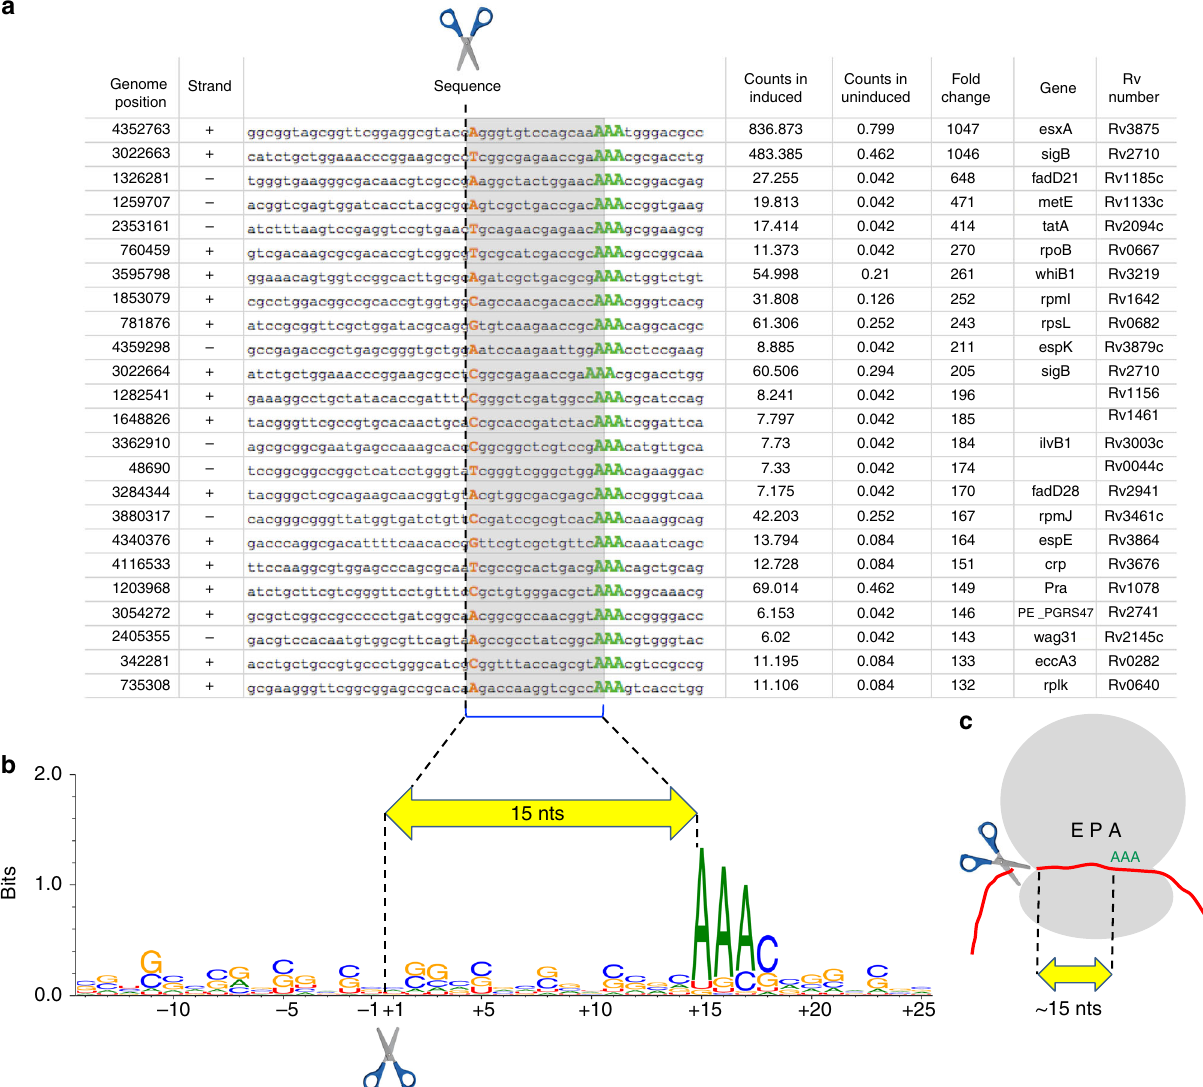
Fig. 2 5 ′ RNA-seq captures ribosome stalling events at AAA Lys codons. a Top mRNA hits detected by 5 ′ RNA seq, ±25 nts surrounding the cleavage site (scissor). The fi rst nucleotide of each mapped read, orange; AAA Lys codons, green. Counts are represented as reads per million (rpm). b Nucleotide frequency logo (weblogo, see ref. 37 ) at each position constructed from the top 50 of the 181 mRNA hits identi fi ed. Positions numbered relative to the cleavage site. c Schematic of a ribosome (gray) and the ~15 nt length (yellow arrow) from the 5 ′ end of transcript to the A-site. Source data are provided in Supplementary Data